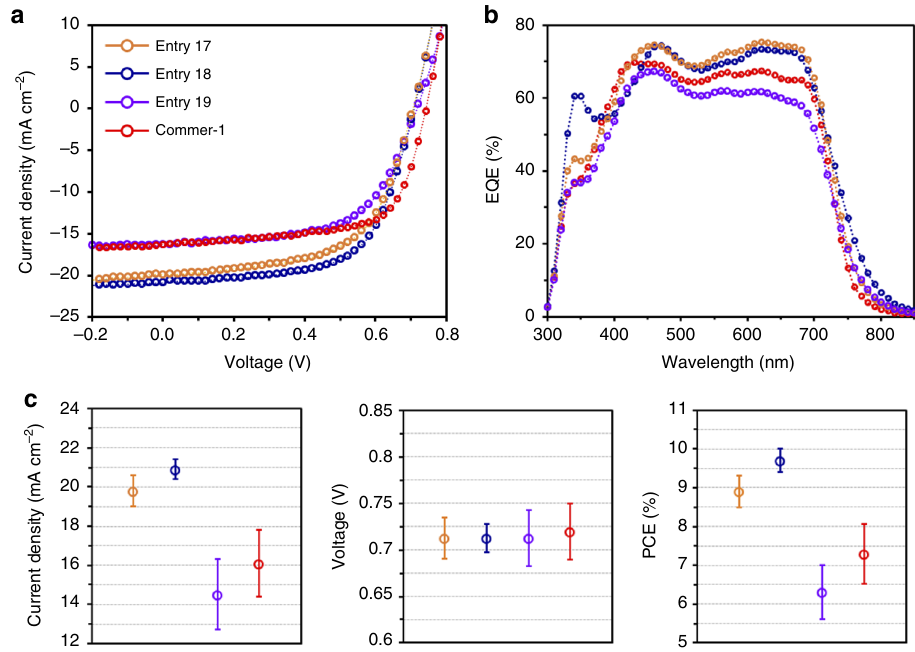
Fig. 4 Photovoltaic performance from the selected entries and Commer-1. a J – V characteristics for BHJ solar cells. b EQE spectra in a range from 300 to 850 nm. c Variations in device parameters of J SC s, V OC s, and PCEs. All error bars with average values were obtained from more than 30 devices for each polymer